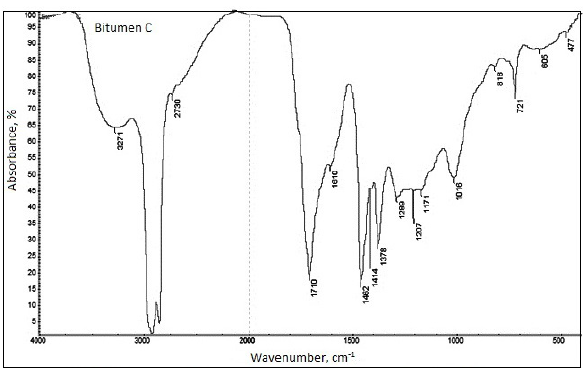
Fig. 4. IR spectrum of bituminous C extracted from Uvur- jargalant’s oil